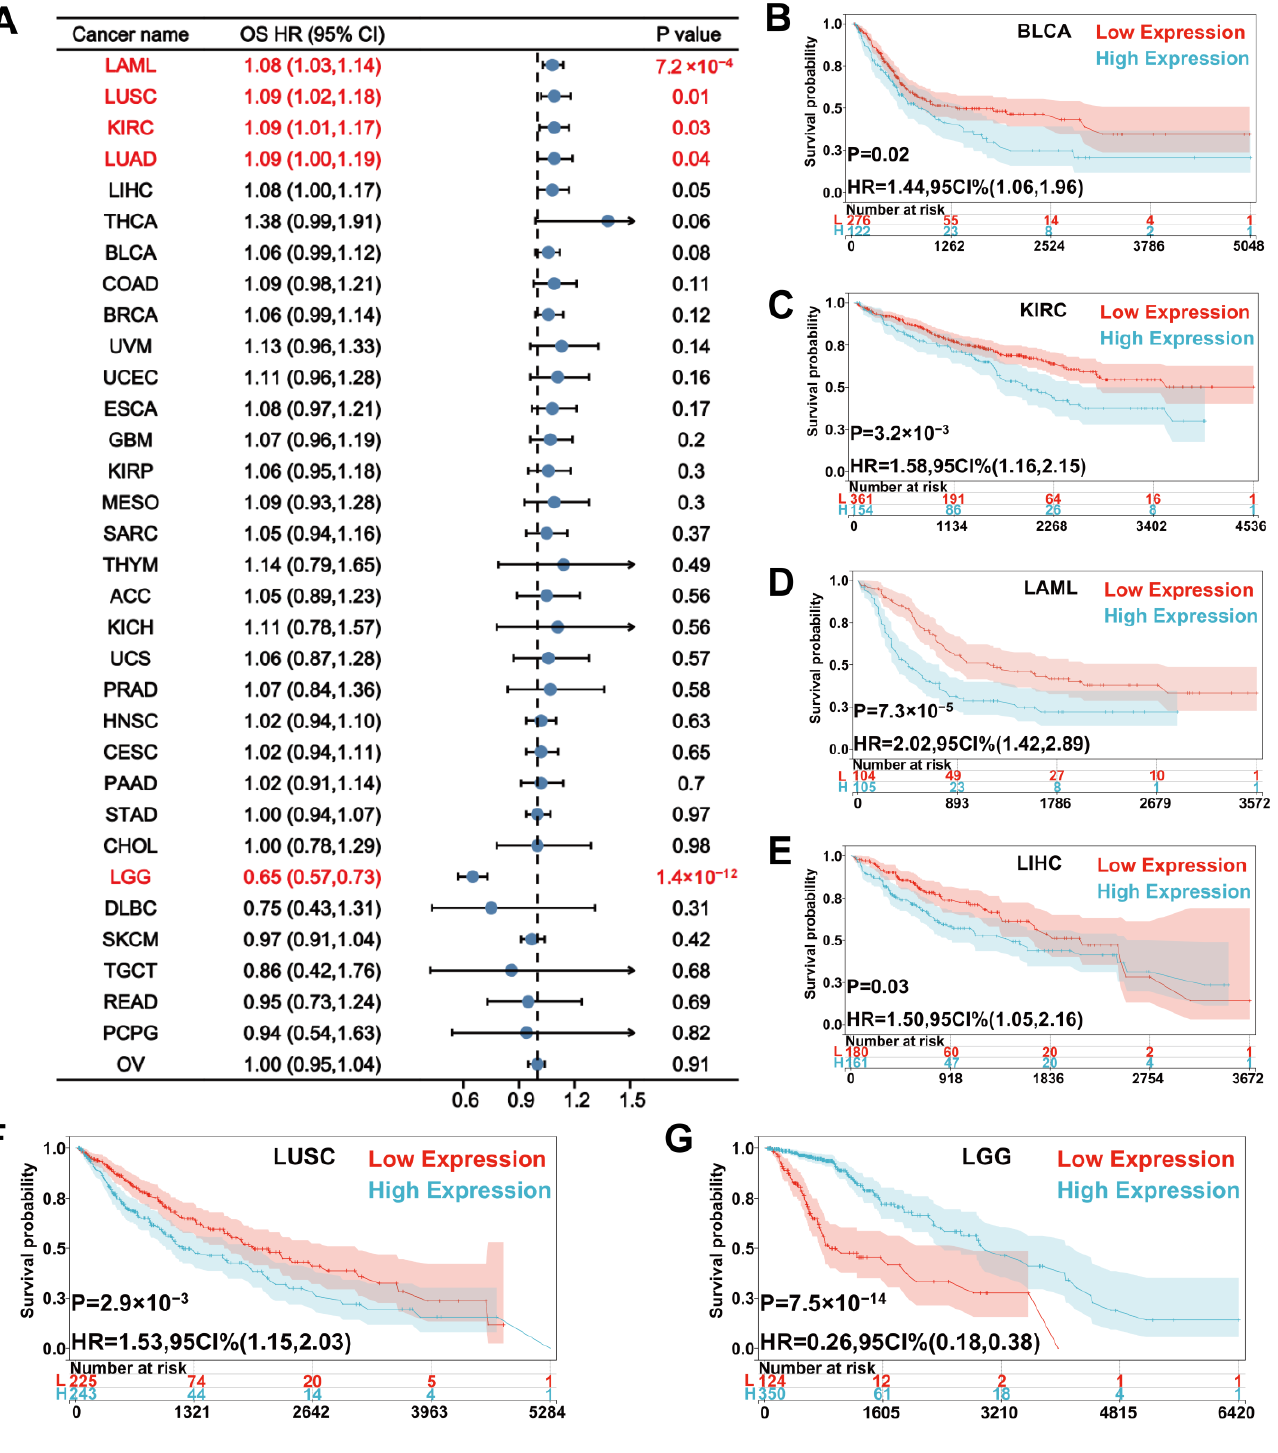
Figure 2. Relationship between UNC5A expression and patients’ OS in pan-cancer. ( A ) The forest plot shows the relationship of UNC5A expression with OS in pan-cancer. ( B – G ) Kaplan-Meier analysis shows the association between UNC5A expression and OS in pan-cancer. For DFI, Cox regression showed that a high UNC5A level was a risk factor for LUSC (HR = 1.20, P = 0.01) and testicular germ cell tumors (TGCT, HR = 1.41, P = 0.01) but served as a protective factor for pheochromocytoma and paraganglioma (PCPG, HR = 0.57, P = 2.1 × 10 −5 ), and LGG (HR = 0.70, P = 0.03), as shown in Figure 3A. Kaplan-Meier curves